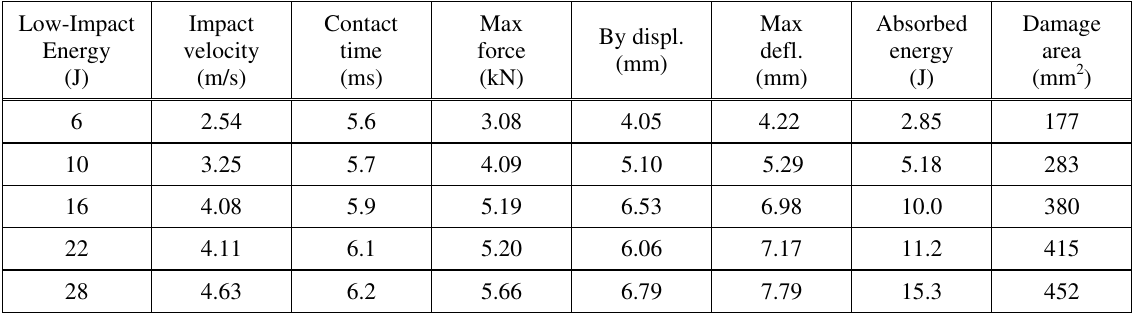
Table 2. Experimental results of low-energy impact tests